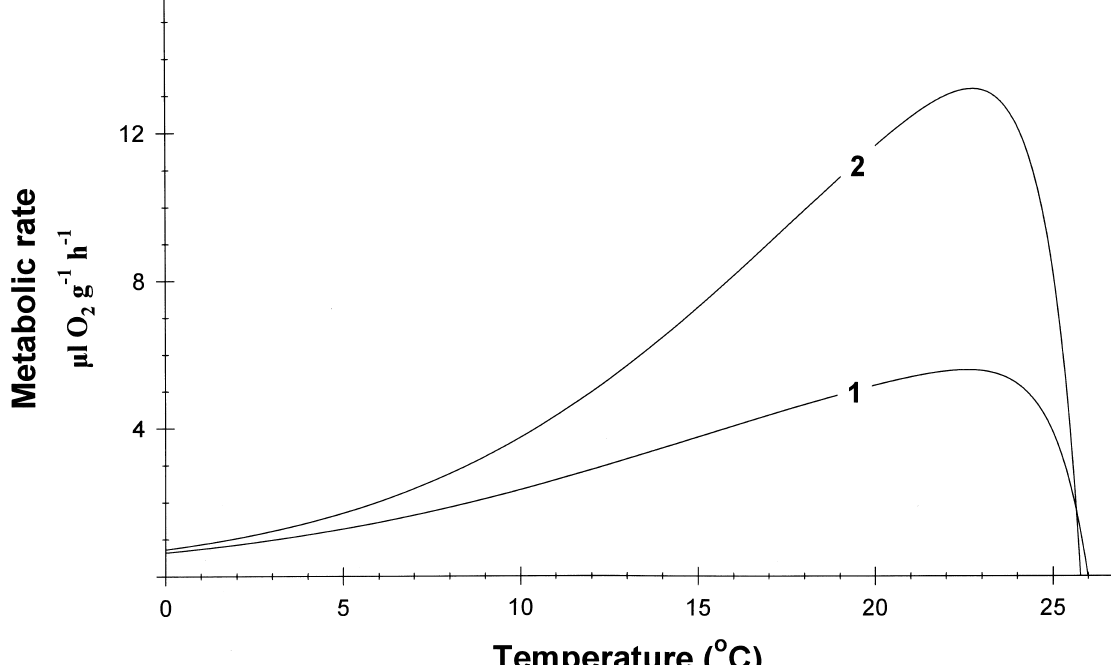
Fig. 4. Relationship of metabolic rate to temperature in adult G. balcanica fed on contaminated food. 1: specimens short-term acclimat- ed to constant temperatures (up to 5 days), 2: specimens mid-term acclimated to constant temperatures (43 days).